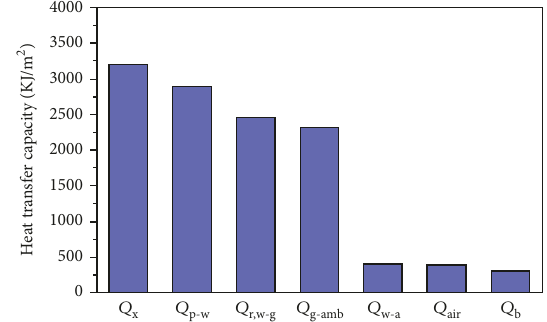
Figure 9: Heat transfer between the di ff erent components of chimney during the nighttime.